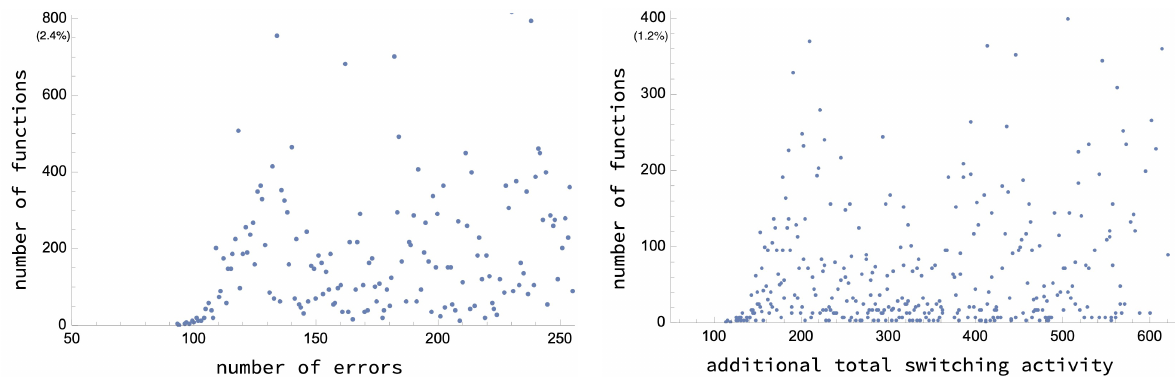
Figure 2. A search scheme for majority approximators.